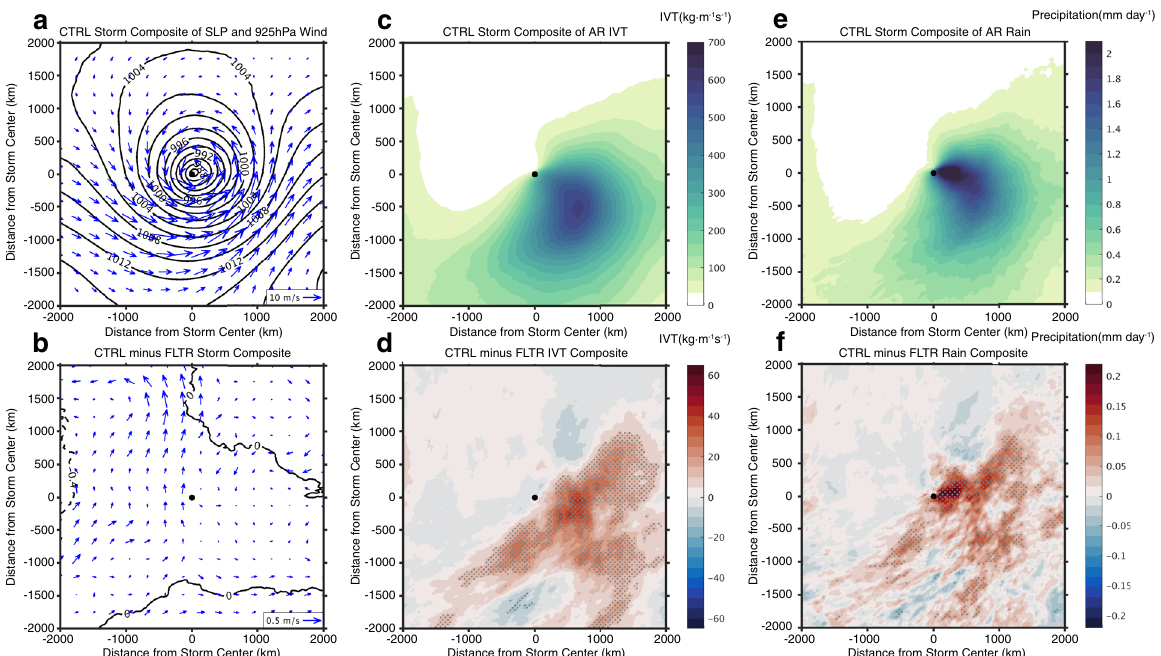
Fig. 6 Composite of extratropical cyclones in the cyclone ensemble experiment. Composite of sea level pressure (SLP, contours, hPa) and 925hPa wind (vector, ms − 1 ) of all identi fi ed extratropical cyclones in cyclone-ensemble control (CE CTRL) ( a ), and the corresponding differences between CE CTRL and fi ltered (FILT) ( b ). The black dot indicates the center of composite cyclone. c , d same as a and b , but for composite of AR integrated water vapor transport (IVT) associated with extratropical cyclones. e , f same as a and b , but for composite of AR-induced precipitation. The difference above 95% con fi dence level based on a two-sided Student ’ s t test is shaded by gray